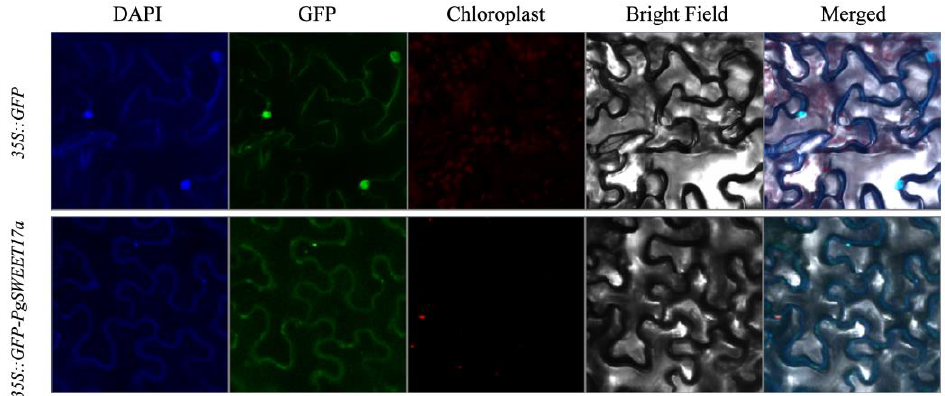
Figure 8. Subcellular localization of the 35S::GFP-PgSWEET17a fusion protein in tobacco leaves. Free GFP served as a control. A DAPI staining assay was conducted to confirm the nuclear localiza- tion.